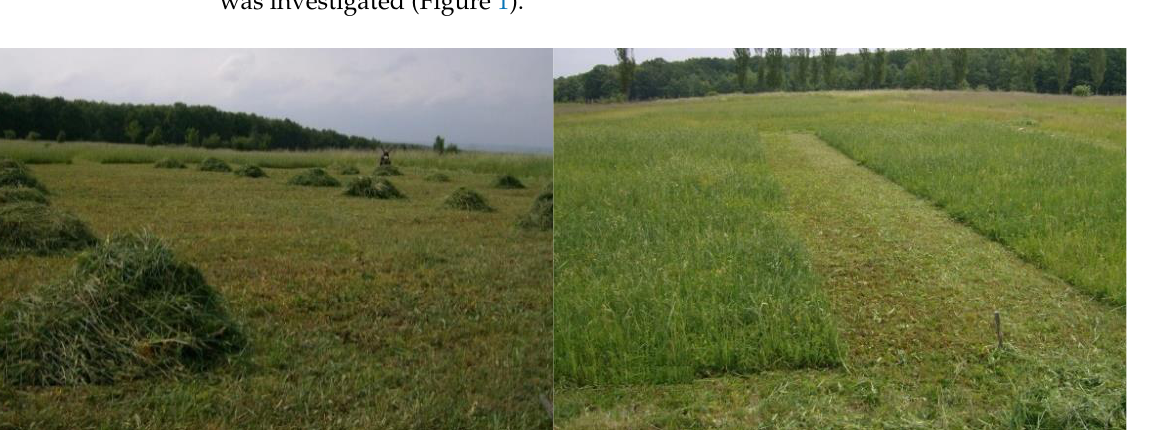
Figure 1. Aspects of the research field.